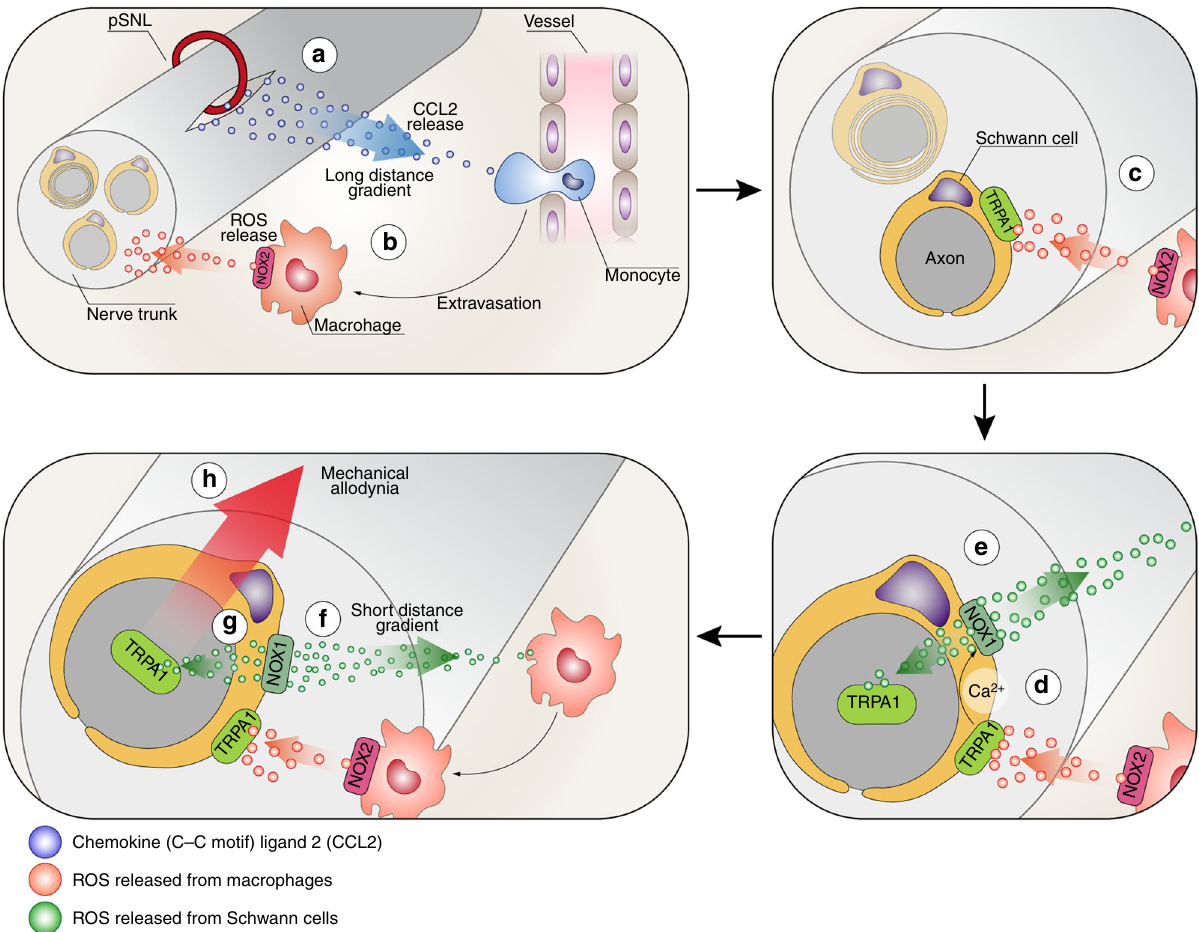
Fig. 9 Cellular and molecular events contributing to TRPA1-mediated mechanical allodynia and neuroin fl ammation in a neuropathic pain model. Partial sciatic nerve ligation (pSNL) by releasing CCL2 ( a ) promotes the extravasation of hematogenous monocytes ( b ) that, via their rapid NOX2-dependent oxidative burst (red dots) target the TRPA1 channel localized in Schwann cells ( c ). TRPA1 activation in Schwann cells evokes a Ca 2+ -dependent, NOX1- mediated ( d ) prolonged H 2 O 2 (green dots) generation ( e ) with a dual function. The outward H 2 O 2 release ( f ) produces a space-scaled gradient that determines the fi nal macrophage in fl ux to the injured nerve trunk, whereas the inward H 2 O 2 release ( g ) targets nociceptor TRPA1 to produce mechanical allodynia ( h ). ROS reactive oxygen